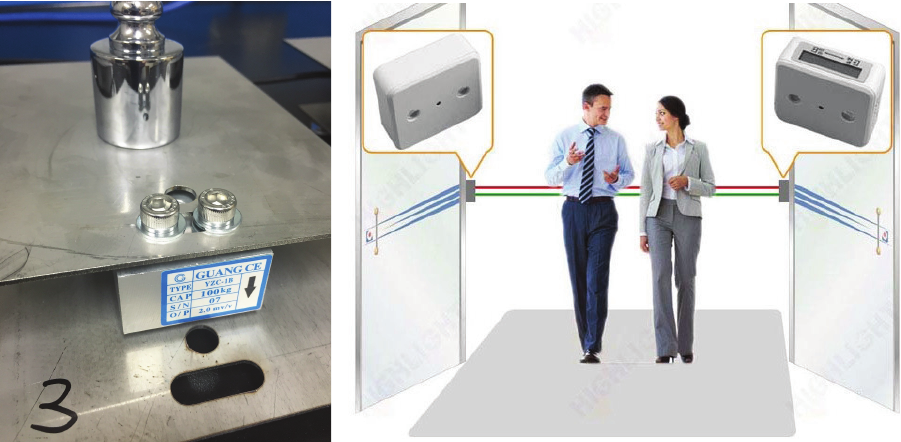
Figure 14. Load cell ( left ); people counter ( right